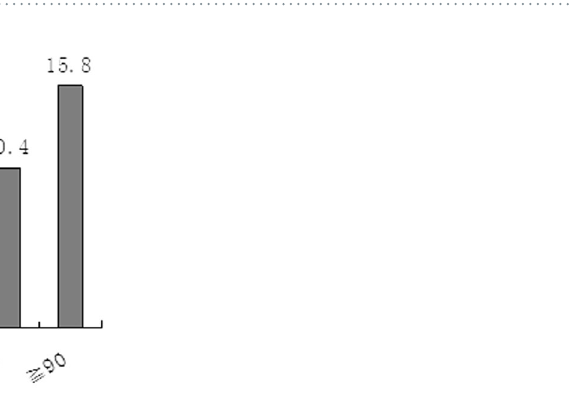
Figure 3. Correlation of morbidity and mortality of risks in hypertensive women. The incidences of pneumonia (A) increase with age (black bars); the death rates increase with age as well in general (white bars), resulting in the correlation coefficient between them significant ( P < 0.05, r = 0.77). The correlation coefficient between incidences and mortalities in different ages from all other risks ( B , coronary heart disease; C , cerebral infarction; D , diabetes) is not significant.